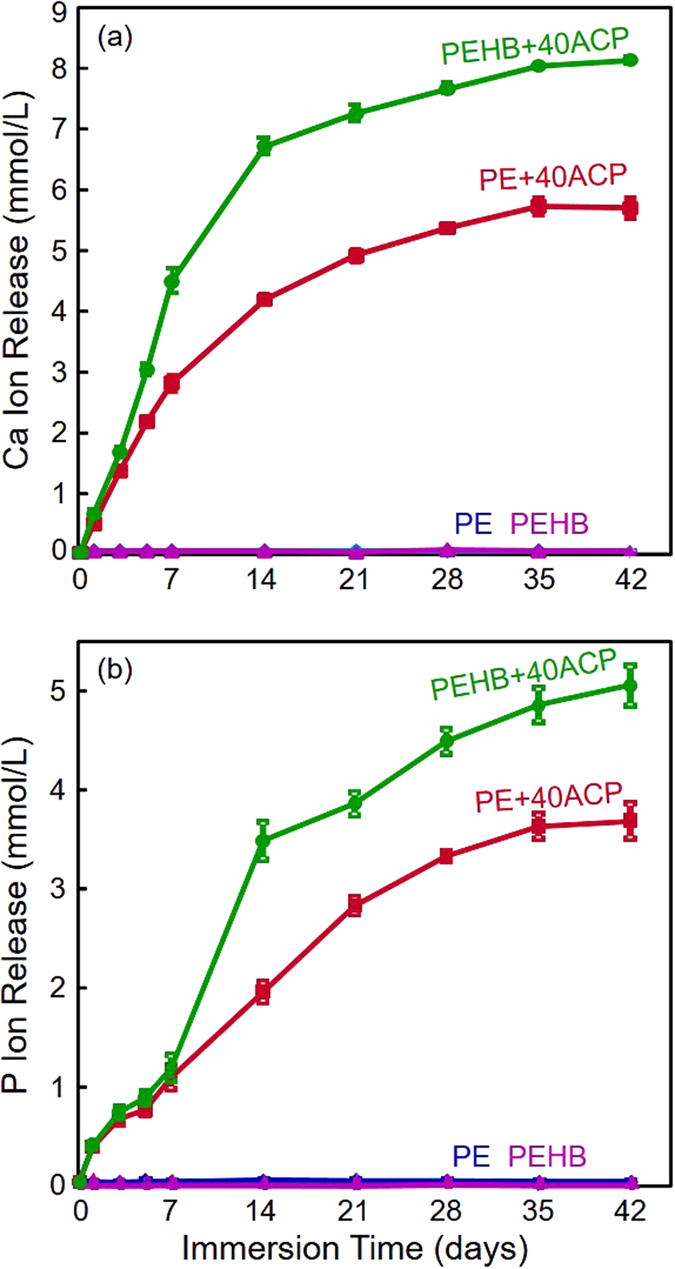
Initial Ca and P ion release (mean ± sd; n = 6) from the orthodontic cements: (a) Ca ion release, and (b) P ion release. PEHB+40ACP showed significantly higher Ca and P ion releases than PE+40ACP (p < 0.05).